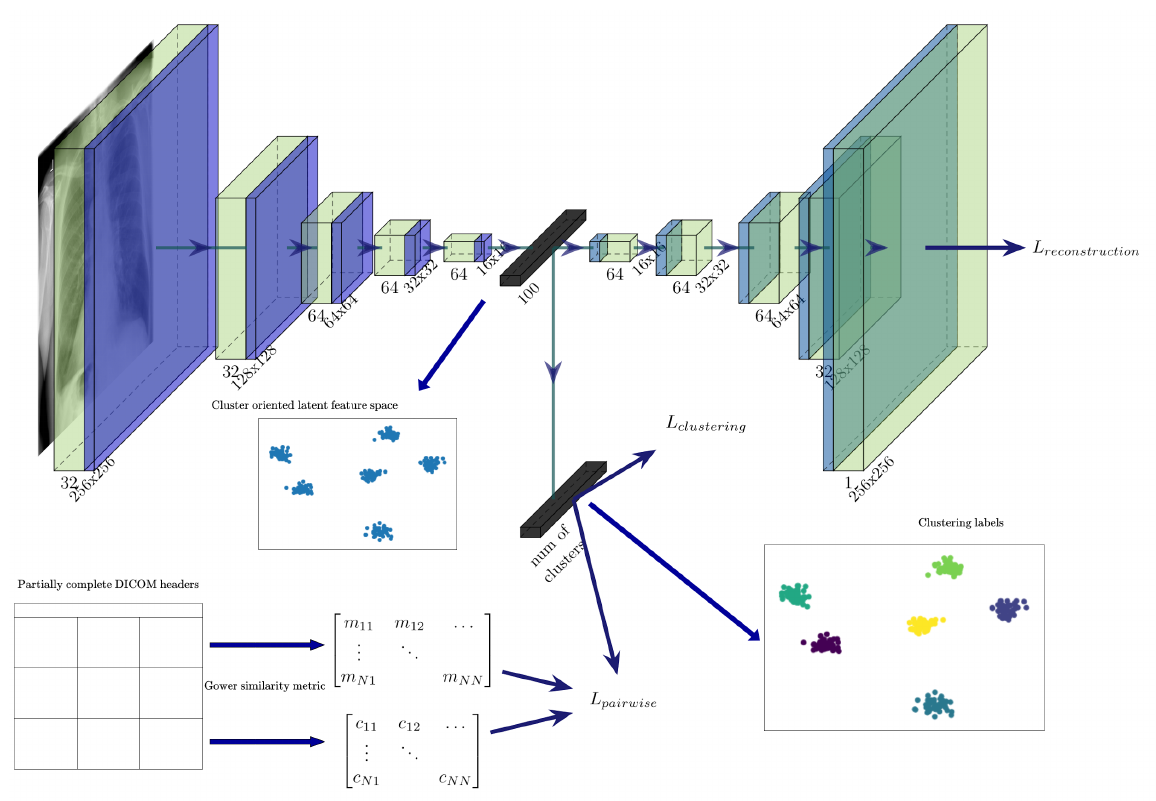
Figure 4. The architecture of the proposed semi-supervised algorithm for learning cluster-oriented representations. To better illustrate how model training is performed, detailed pseudocode is shown in Algorithm 1. Algorithm 1 Semi-supervised model-training algorithm utilising DICOM tags and